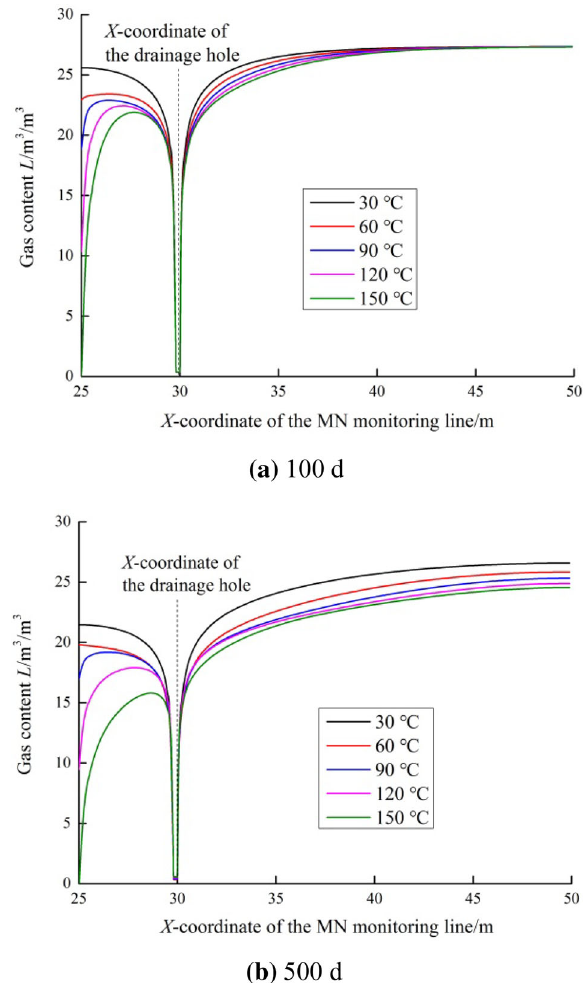
Fig. 7 Residual gas content distribution on the monitoring line MN with different injection temperatures after 100 d and 500 d injection